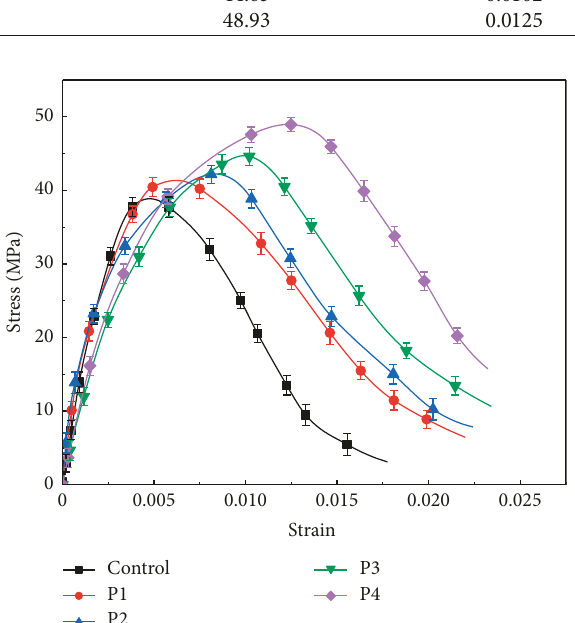
Figure 8: Stress-strain curves of AAS mortars. The error bars represent the standard deviation of nine test specimens.